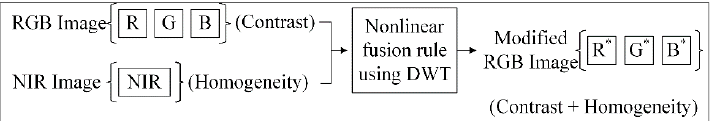
Figure 7. Modification of the original RGB color image with the corresponding NIR image using the proposed fusion approach.